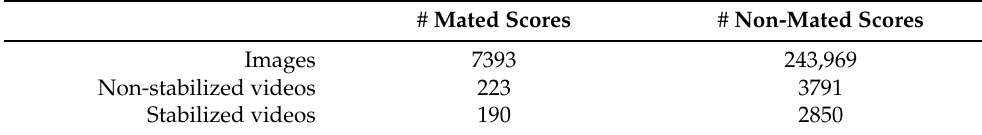
Table 1. Number of similarity scores per experiment.